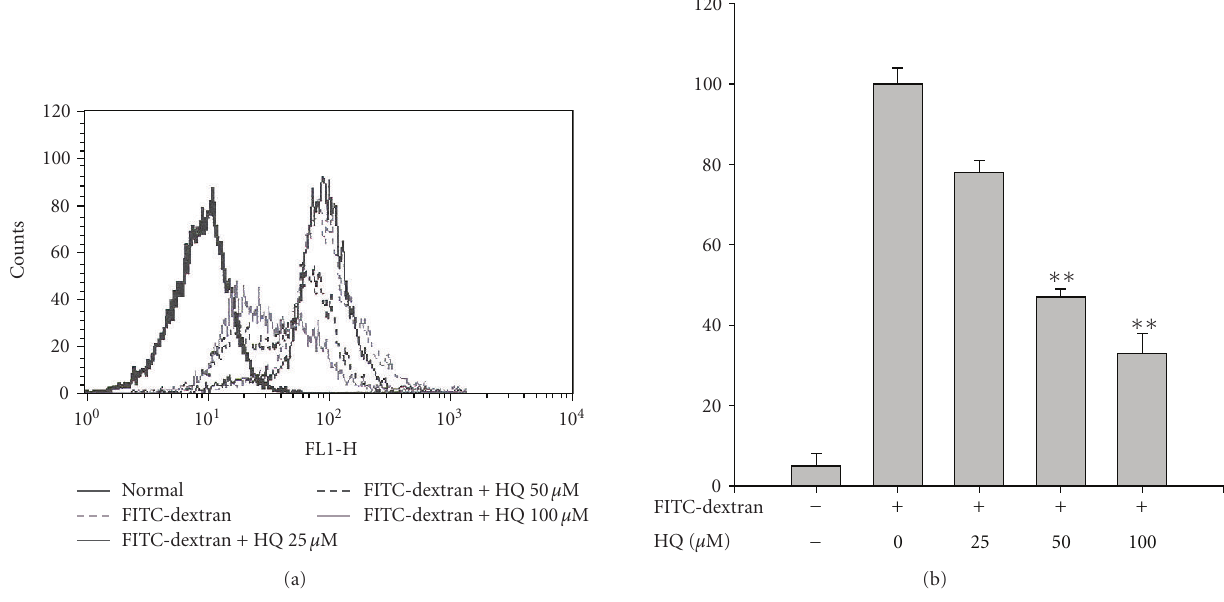
Figure 5: E ff ect of hydroquinone on the phagocytic uptake of FITC-labeled dextran. RAW264.7 cells (1 × 10 6 ) were incubated with in the indicated concentrations of HQ (hydroquinone) in the presence or absence of 1 mg/mL of FITC-labeled dextran for 30 minutes. The uptake of dextran was detected by flow cytometric analysis as described in Section 2. ∗∗ p < . 01 represents significant di ff erence as compared to